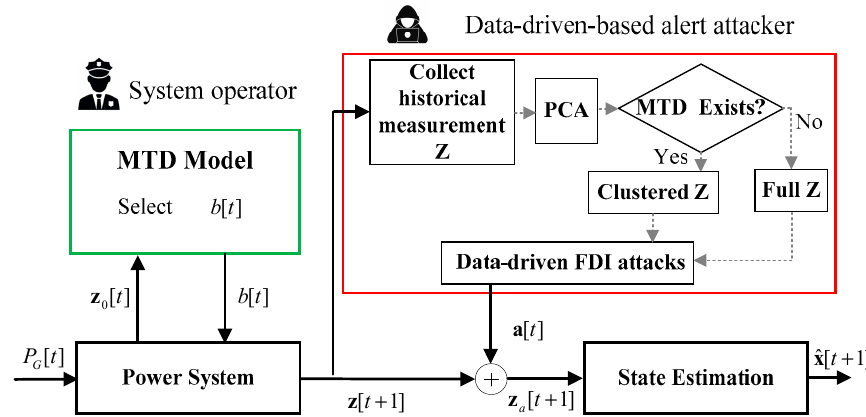
Figure 2. The attack logic flowchart of the data-driven alert attacker.